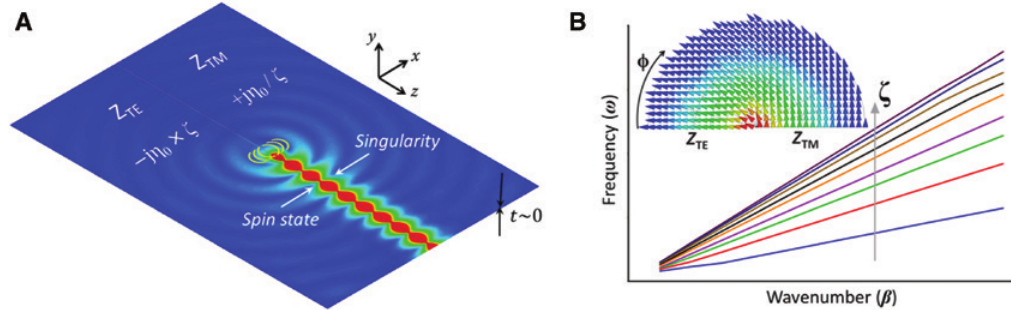
Figure 1: Formation and ideal characteristics of line wave. (A) Magnitude distribution of the E-field across the interface between complementary TE and TM impedance surfaces showing the line wave formation with a direction-dependent polarization (pseudo-spin state) and maximum – ideally singular – field concentration along the inter- face line, and (B) the associated ideal dispersion relation at variable impedance values, hence confinement rates, as well as a vector plot of the E-field – in inset – showing the field’s intensity decay in the radial direction away from the interface line, and the change in the field’s vector orientation at different directions in the transverse plane to the interface